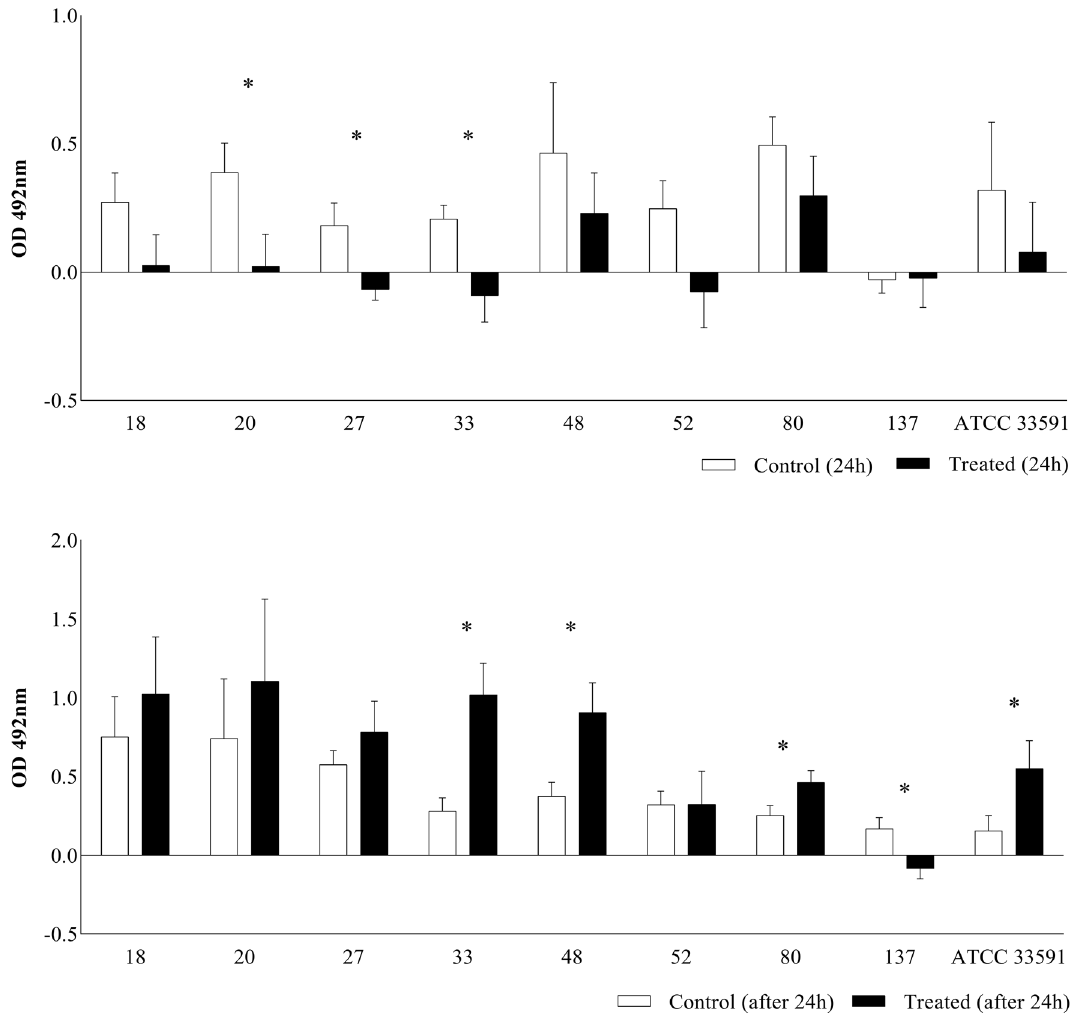
Figure 2. Biofilm formation capacity of the MRSA strains (18, 20, 27, 33, 48, 52, 80, 137) and ATCC 33591 control treated with 25 mg/mL (2.5%) citral for 24 h and with the addition of 2.5% citral after 24 h of the formed biofilm represented in a quantitative way. The experiment was carried out in quadruplicate with two independent experiments. Significant difference at P ≤ 0.05 Antibiograms were also analyzed using the heatmapper platform (http:// www. heatm apper. ca/ expre ssion/), and differentiated modulating activity patterns induced by different strains of MRSA were observed. The heatmap separated the isolates into three distinct clusters (cluster 1: ATCC 33591 and strain 80; cluster 2: strains 48, 27, 137, 18, 33, and 20; cluster 3: strain 52) and, together with the qPCR data, showed different expression patterns induced by different strains of MRSA (Fig. 1). Biofilm formation capacity of the MRSA were represented in a quantitative way in MRSA isolates using citral in the initial phase of biofilm formation from 0 to 24 h, along with the addition of citral in the mature phase of the biofilm, corresponding to 24 h after inoculation. The concentration of 25 mg/mL (2.5%) of citral was more effective in isolates with citral added in the initial phase of biofilm formation than in the mature phase. In the initial phase, there was a significant reduction in biofilm formation, as isolate 20 (93.6% reduction), and thus isolates 27 (62.5% reduction) and 33 (55.71% reduction). In the mature phase, isolate 137 (51.2% reduction) after 24 h of growth was the only isolate showing a positive result. Thus, it was observed that using citral in the initial phase of biofilm formation presented better results (Fig. 2). To confirm the results of biofilm inhibition, we visualized its structural organization using confocal micros- copy. Citral treatment substantially reduced S. aureus biomass, with a decrease in living and dead cells (Fig. 3), consistent with what was observed in the plate biofilm. The expression of the virulence genes of the enterotoxins seg , sei , and sej of exfoliative toxins eta and etb and of genes related to the formation of the biofilm, icaA and icaD, were evaluated, considering the characterization of the isolates regarding the virulence genes. Evaluation of the expression of the enterotoxin genes seg and sei (Fig. 4A,B), expression increased in the presence of citral, with significant results for strains 18 (100% increase) and 48 (63.7% increase) for seg, and 18 (93.4% increase), 20 (95.1% increase), 48 (96.8% increase) 52 (84.5% increase), 80 (95.9% increase), 137 (75.8% increase) and ATCC 33591 (98.7% increase) for sei . None of the